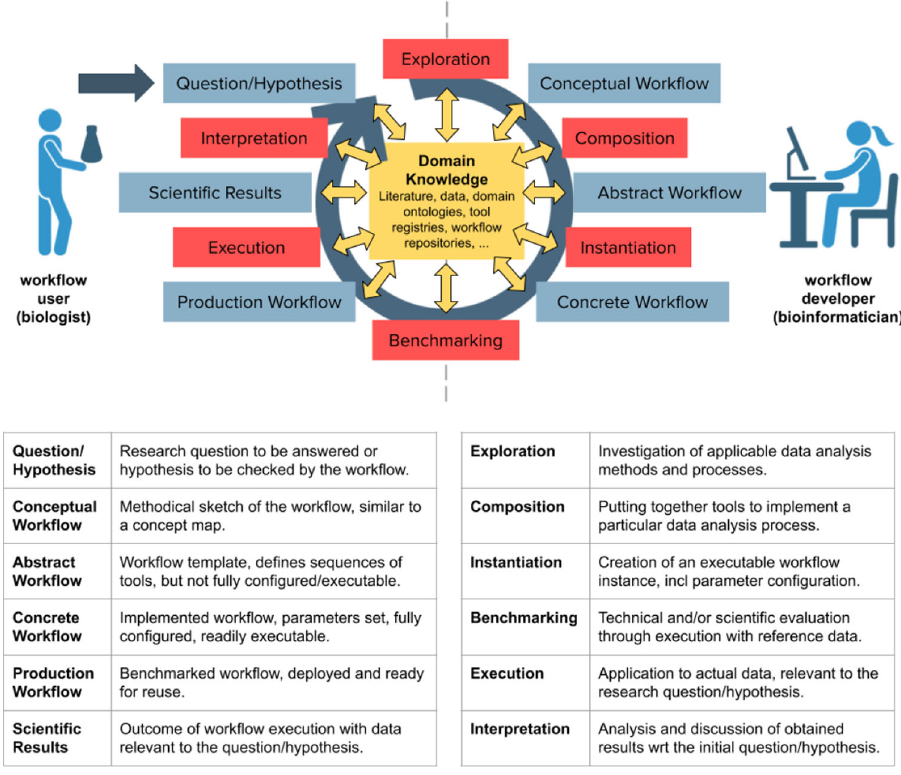
Figure 1. Scientific workflow life